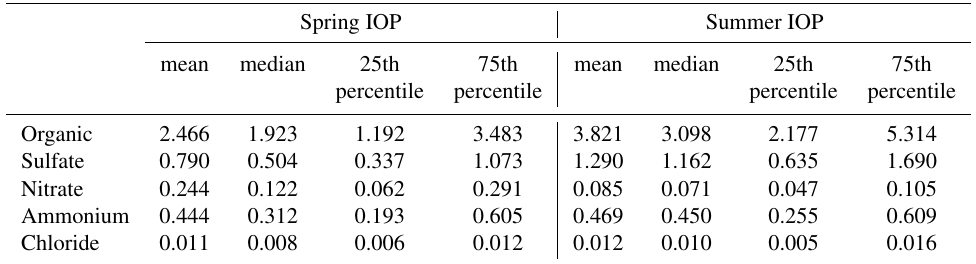
Figure 2. Time series of (a) absolute mass concentrations and (b) fractions of particle chemical composition, measured by the AMS for the spring and summer IOPs during the HI-SCALE campaign. Table 1. Statistics of aerosol chemical composition measured by the AMS at the SGP site during the two HI-SCALE IOPs. Measurement units are µgm − 3 for all